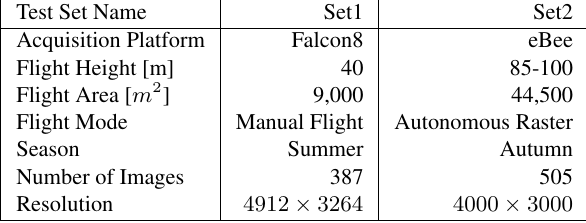
Table 2. Acquisition details of the test